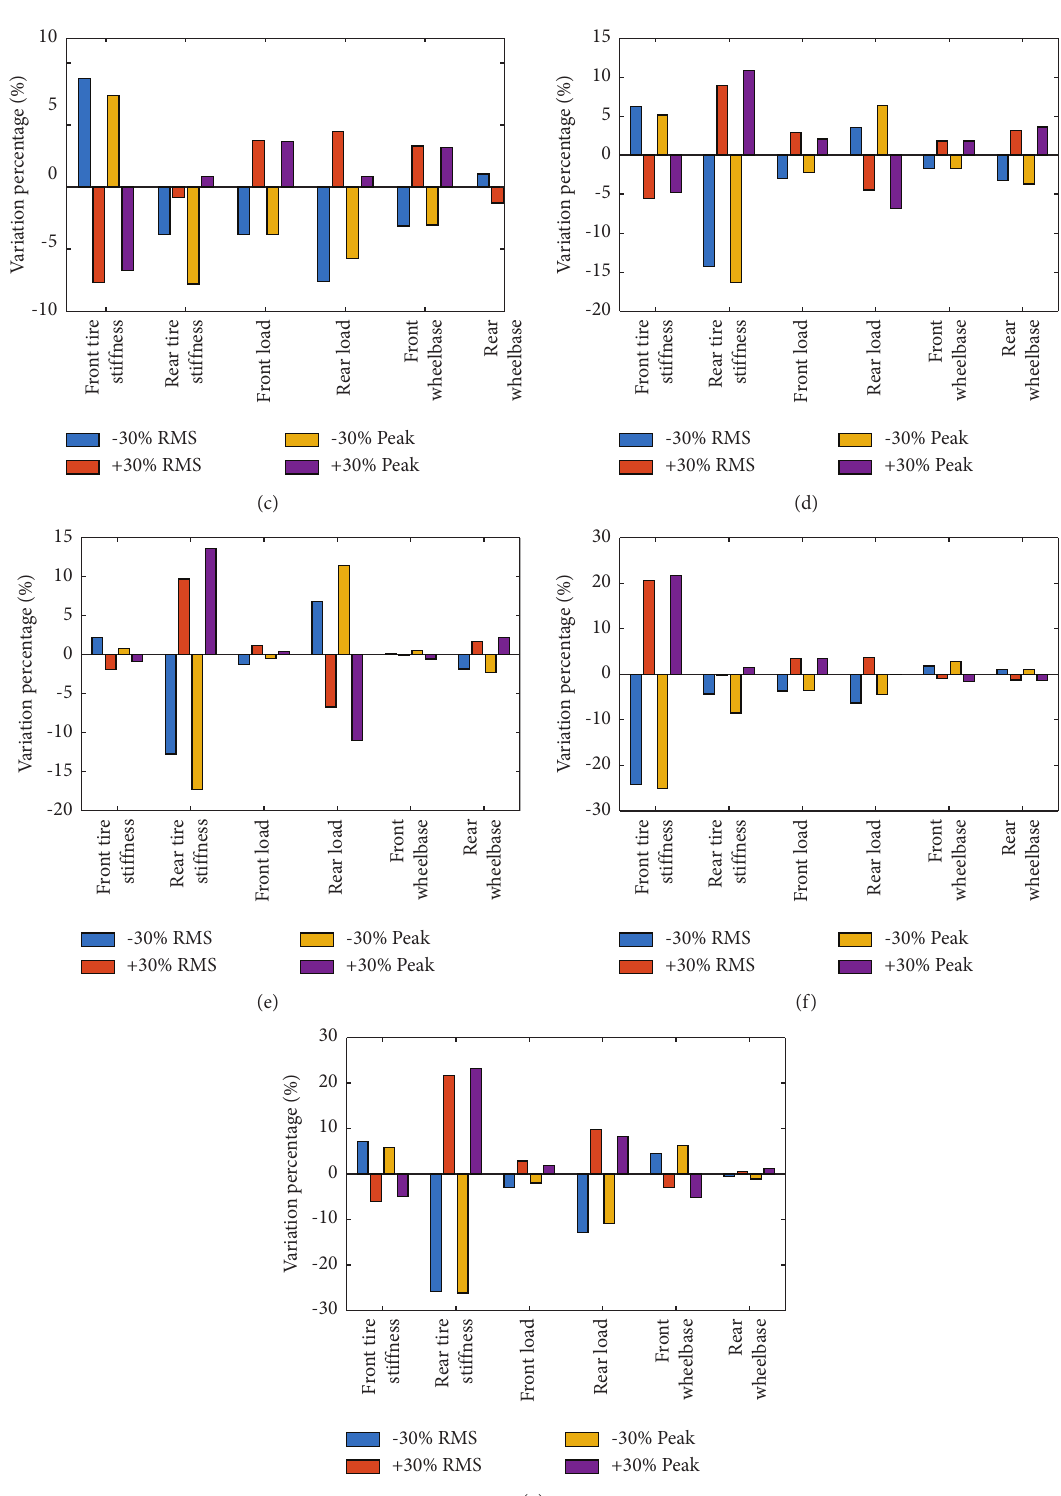
Figure 16: Variation percentage of the vehicle performance criteria compared with the original situation. (a) Front tire sideslip angle. (b) Rear tire sideslip angle. (c) Vehicle sideslip angle. (d) Yaw rate of vehicle front part. (e) Yaw rate of vehicle rear part. (f) Front lateral force. (g) Rear lateral